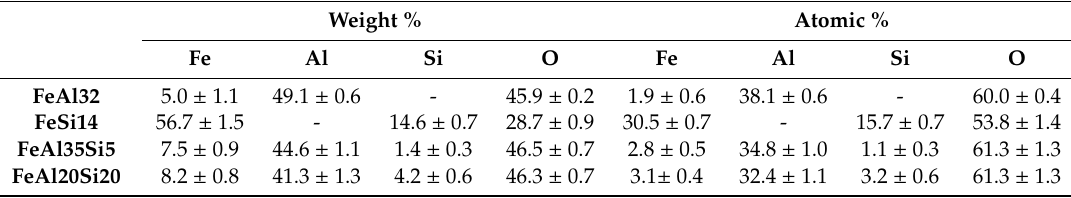
Table 4. Chemical composition of the material below the oxide layer after 300 h of oxidation at 800 °C (in wt %, EDS).